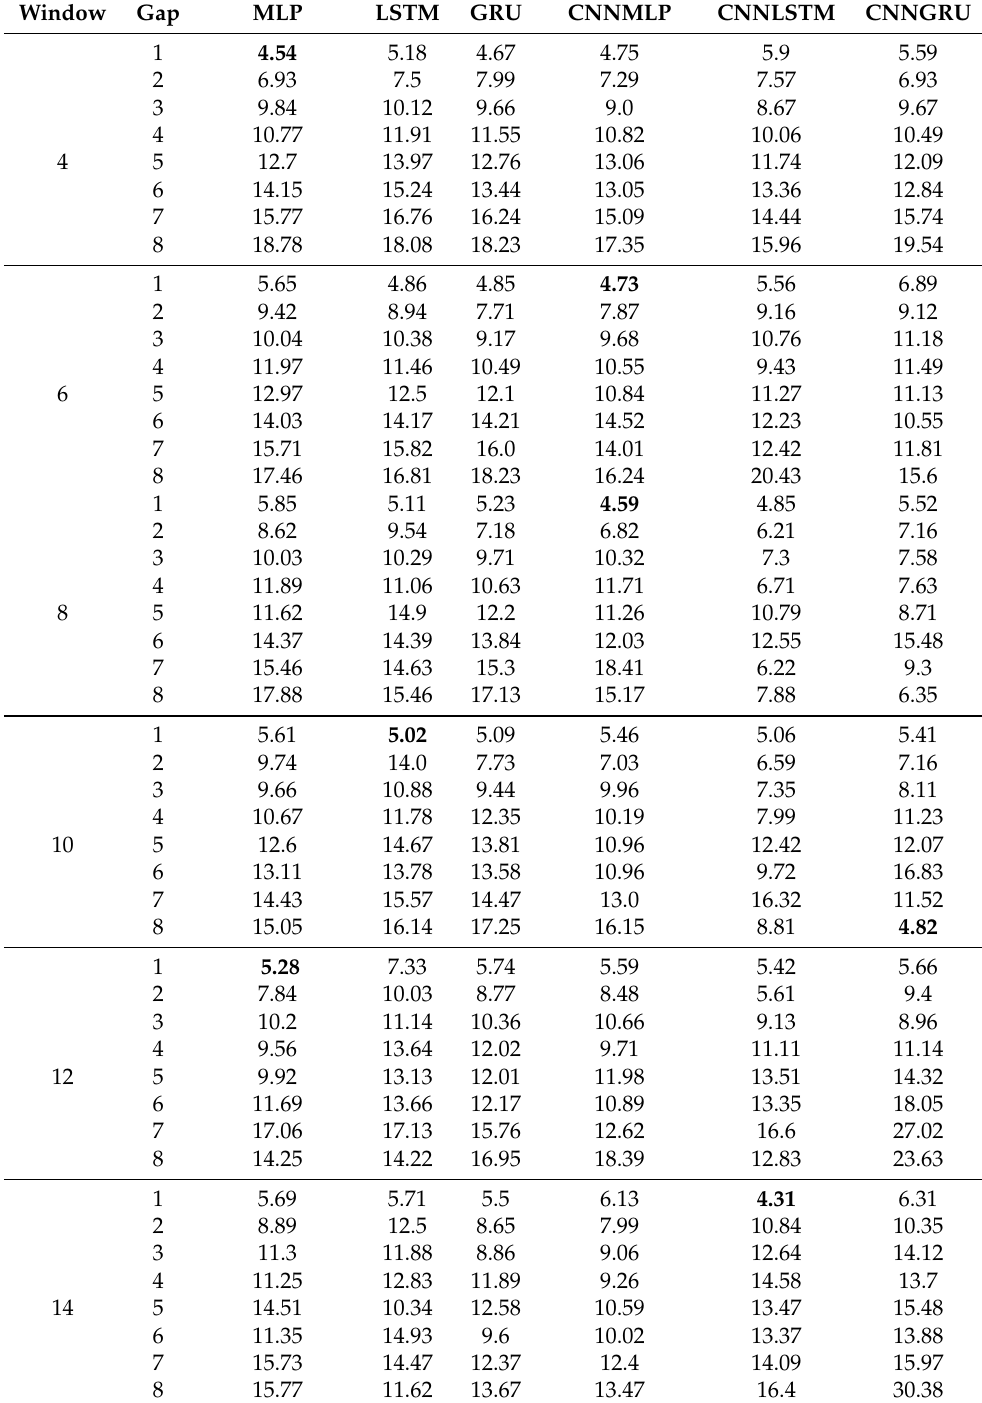
Table 4. MAPE errors of tests with different historical windows (4–14 samples) and gaps (years ahead) ranging from 1 to